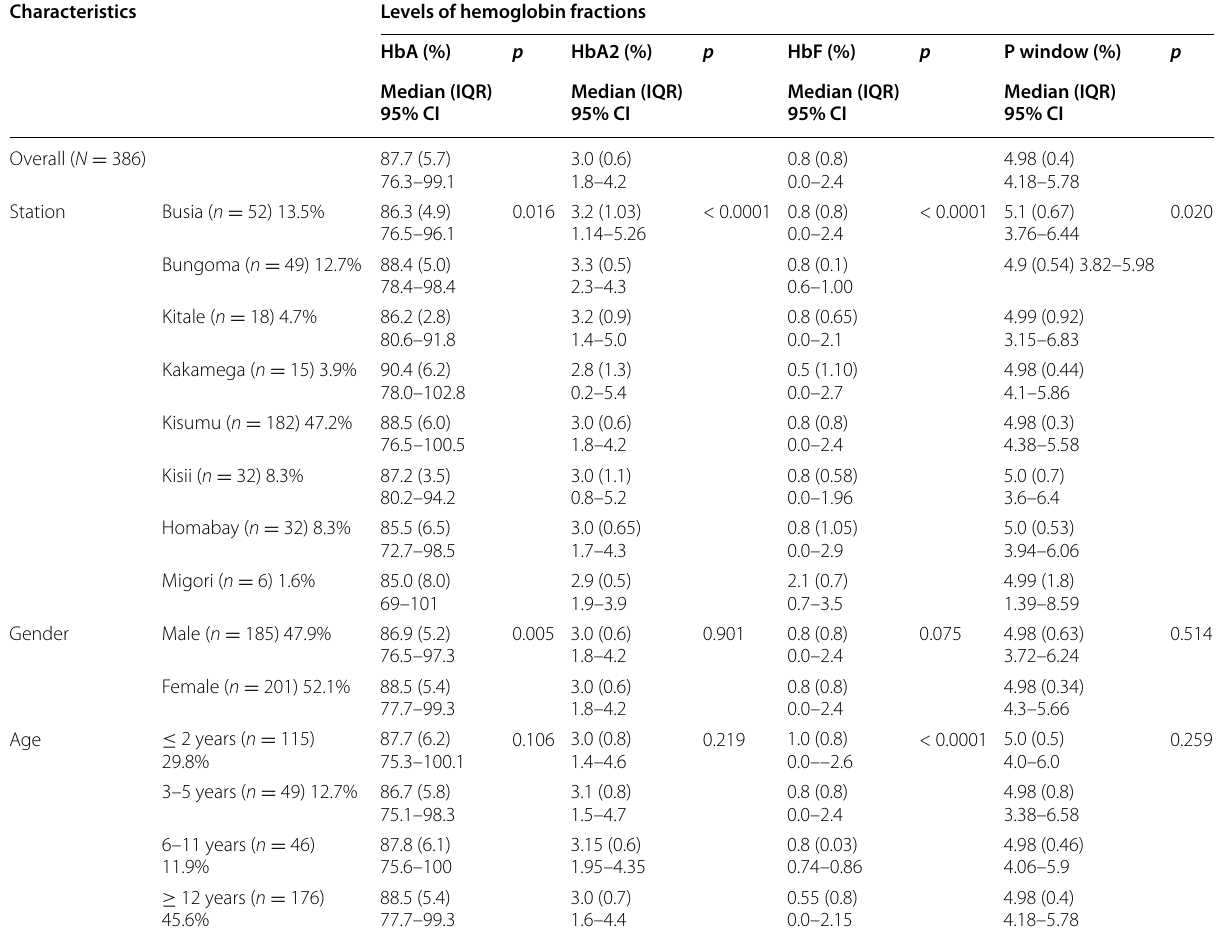
Table 1 Levels of hemoglobin fractions of hemoglobinopathy patients attending Aga Khan Hospital Kisumu, western Kenya, and its satellites